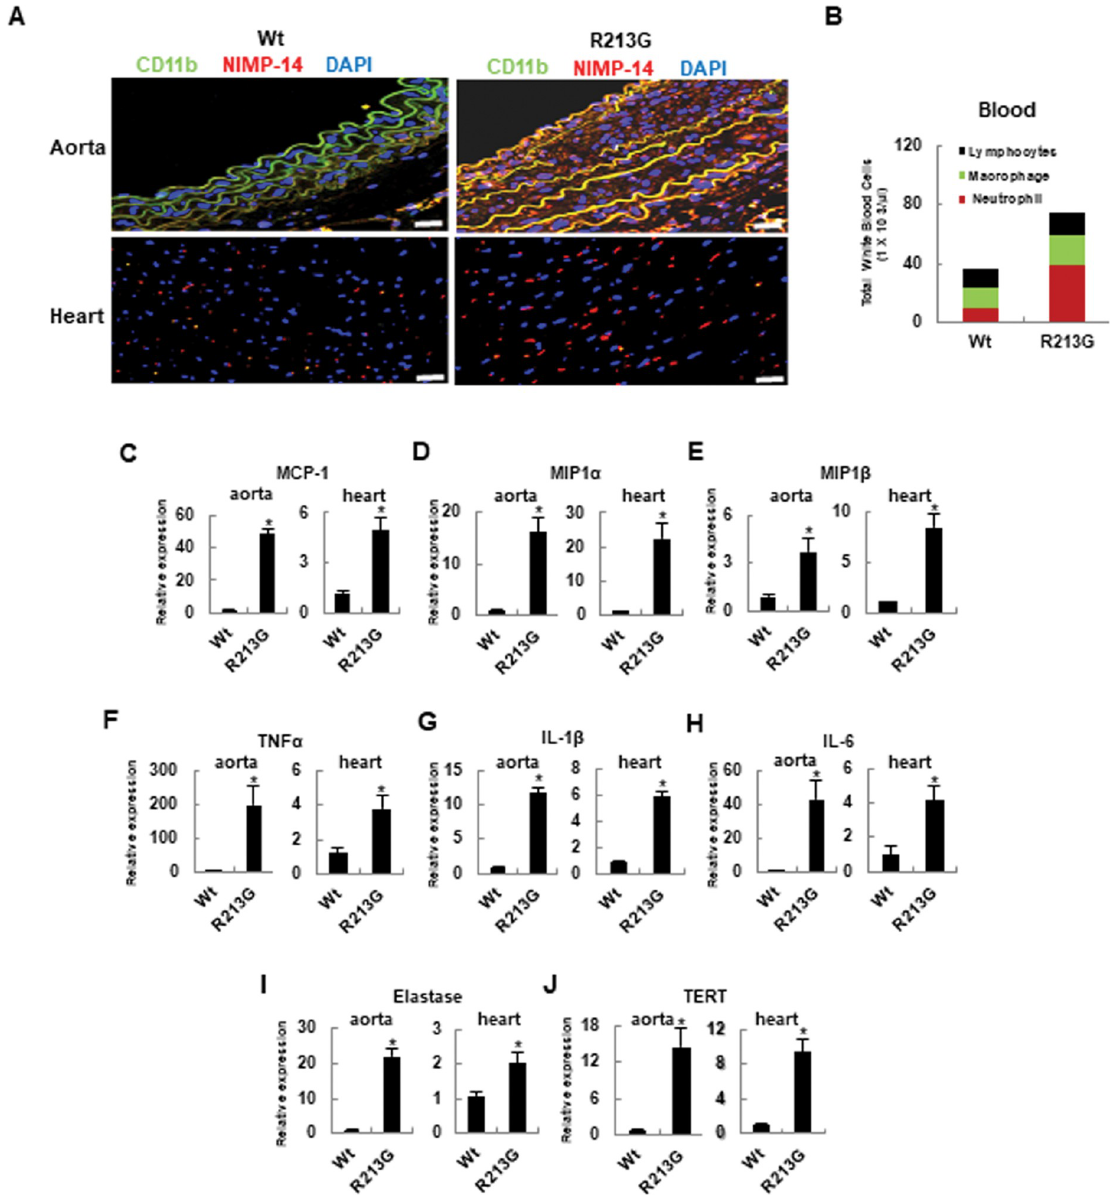
Fig 2. Neutrophils are highly infiltrated in the aorta and heart of SOD3 R213G mice. A . Neutrophils infiltration in the aorta and heart of SOD3 R213G mice. Abdominal aorta (upper panel) and heart (lower panel) of 17 week old SOD3 R213G or Wt mice were isolated, and immunofluorescence staining and confocal analysis were performed as described in Materials and Methods. NIMP-R14: marker for peripheral neutrophils; CD11b: marker for monocytes, neutrophils, granulocytes, and macrophages. Scale bar, 100 μ M. B . Profiles of blood cells. Blood was withdrawn from Wt or SOD3 R213G mice, followed by Diff-Quick Staining. Inflammatory cells, including neutrophils, macrophages, or lymphocytes, were classified as described in Materials and Methods. C-E . Chemo-attractant expressions F-H . Pro- inflammatory cytokine expressions, I and J . Elastase and TERT expressions in the aorta and heart. Chemoattractants MCP-1 (C), MIP1 α (D), MIP1 β (E), and proinflammatory cytokines TNF α (F), IL-1 β (G), IL-6 (H), and elastase (I), and TERT (J) expression in the aorta and heart of 17 week old SOD3 R213G or Wt mice was assessed by qRT PCR. Immunofluorescence data are representative of at least three independent experiments. All qRT-PCR data were analyzed as Fig 1I–1M. Statistical analysis was performed by t - test ( � p <